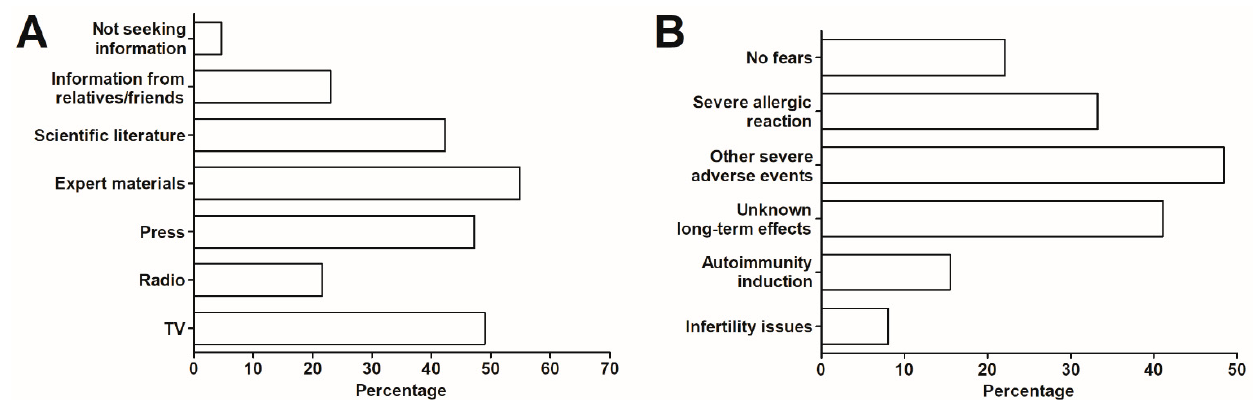
Figure 2. ( A ) The main sources of information regarding the COVID-19 vaccines and ( B ) primary reason of fear over the COVID-19 vaccination ( n = 1020).